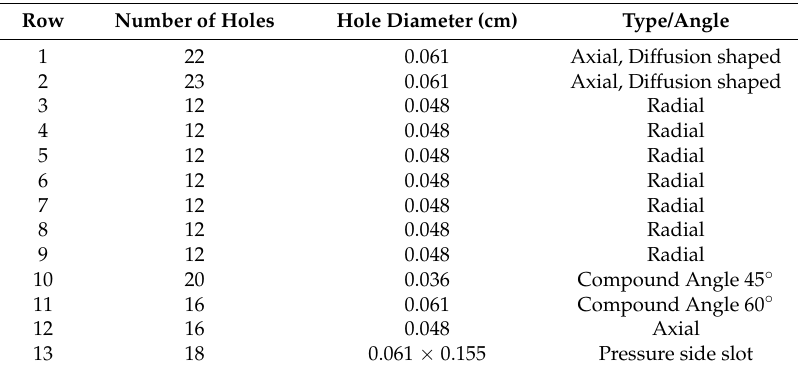
Table 1. Details of film holes